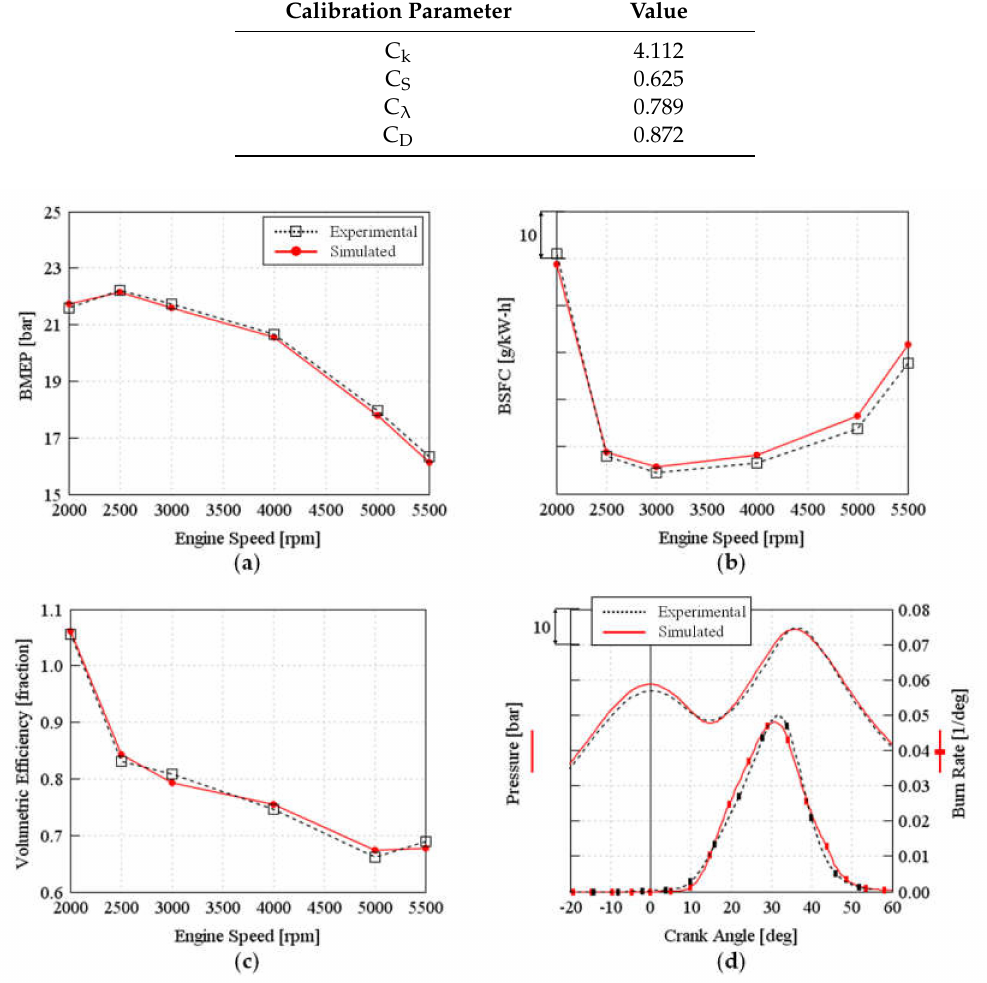
Figure3. ( a )BrakeMeanE ff ectivePressure( b )BrakeSpecificFuelConsumption( c )VolumetricE ffi ciency (Manifold) ( d ) Pressure Cycle (left) and Burn rate (right) at 3000 rpm obtained at Full-Load operating conditions without Port Water Injection; simulated (red solid line) and experimental (black dashed